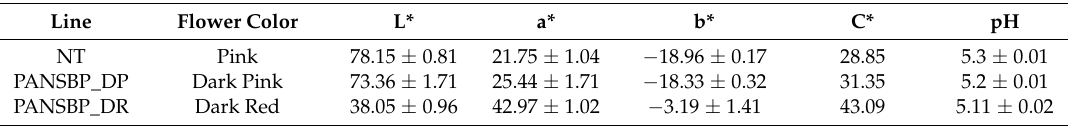
Table 1. Colorimetric parameters of petals at stage S3 of flower development in non-transgenic (NT) and PANSBP transgenic tobacco plants.